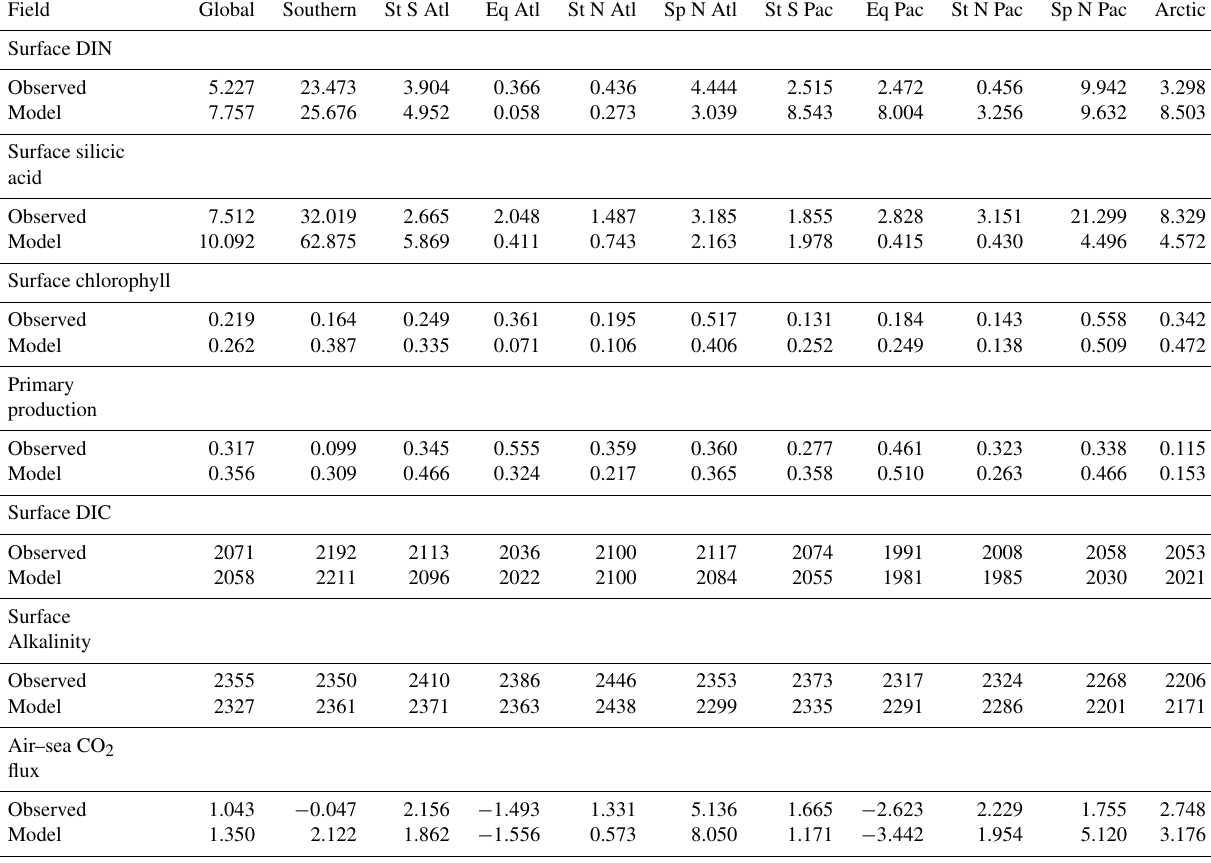
Table 3. Selected biogeochemical properties averaged for specific geographical regions for annual mean fields. Observed and model values shown, with model values averaged over the historical ensemble. Regional abbreviations are “St” for subtropical (10–40 ◦ ), “Eq” for equatorial (10 ◦ S–10 ◦ N) and “Sp” for subpolar (40–70 ◦ ). In the Southern Hemisphere, the subpolar region falls primarily within the Southern Ocean, although as its northern margin is delineated at − 50 rather than − 40 ◦ N, the southern margins of the southern subtropical Atlantic and Pacific extend to − 50 ◦ N. The Indian Ocean is excluded from this analysis for simplicity. Throughout, the model domain used matches that available from observational